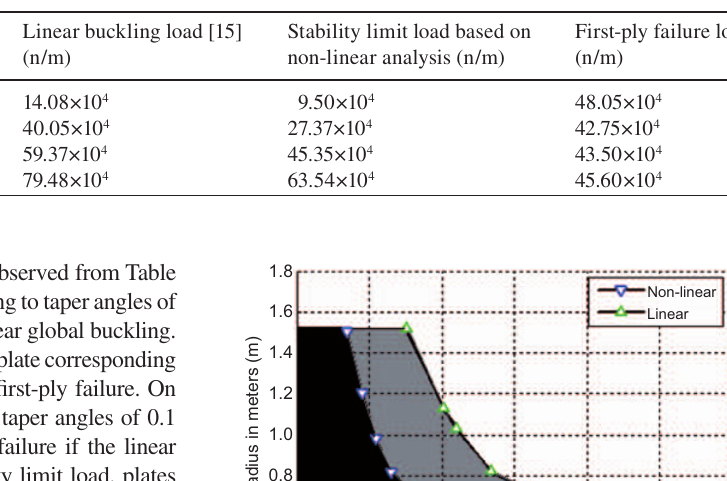
Table 2 Comparison of linear buckling load, stability limit load and fi rst-ply failure load of tapered curved composite plates.